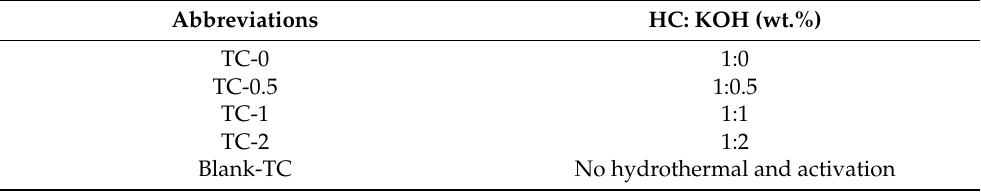
Figure 1. Schematic synthesis of tobacco-stalk-based hierarchical porous carbon (TC). Table 1. Abbreviations and compositions of tobacco activated carbon specimens